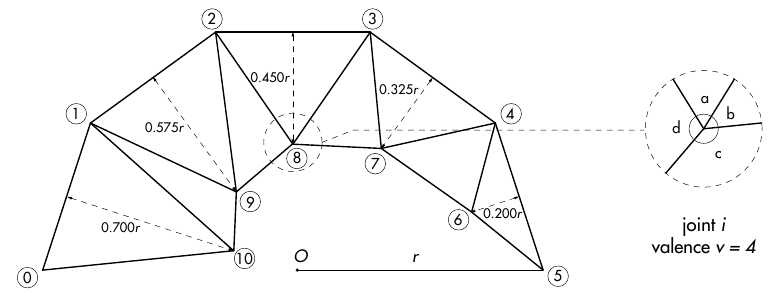
Figure 4. A two-dimensional truss with geometrically varying